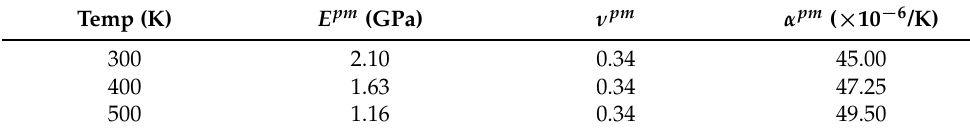
Table 3. The material properties of PmPV [76].